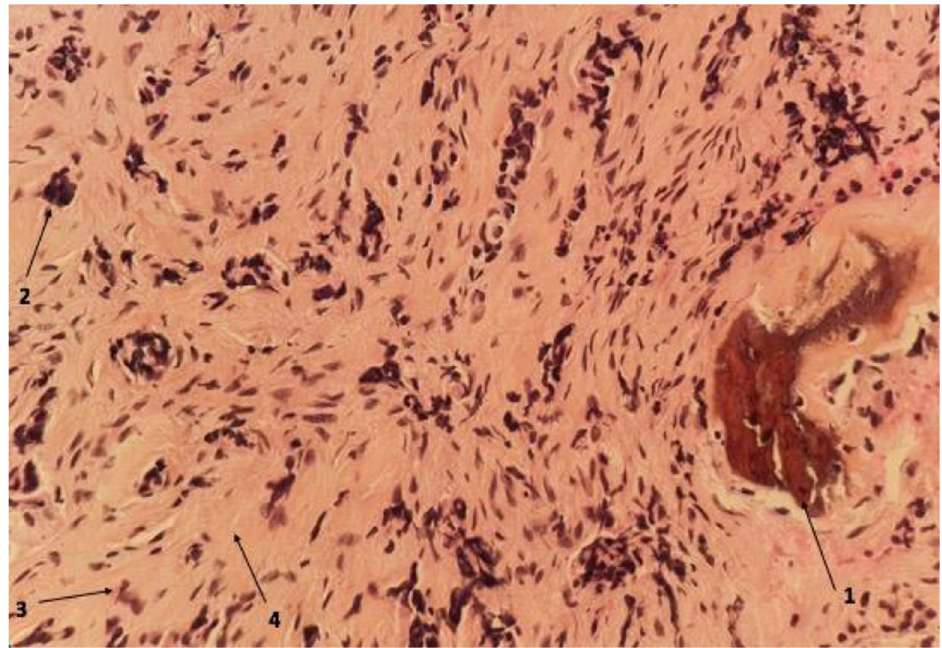
Fig. 3. Section from the mandibular biopsy depicting in fi ltrating ductal breast carcinoma. Stained with hematein, eosin, safran. Magni fi cation (cid:1) 400. 1: bone 2: malignant cells 3: non malignant cells 4: